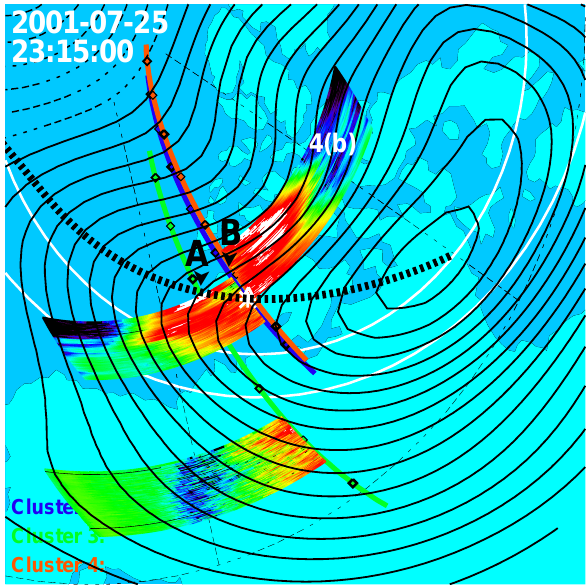
Fig. 5. Composite plot of Cluster magnetic footpoints and iono- spheric convection streamlines for 25 July 2001, at 23:15UT. Over- layed on the magnetic footpoints are 14-min wide sections of the Cluster/CIS flux measurements presented in Plate 1, which are cen- tered on the actual position of the Cluster satellites at 23:15UT. Also indicated by a dashed line is the most likely position of the ion open-closed field line boundary based on the location of the Cluster SC1 satellite position, which entered the cusp at that time, and the SuperDARN convection pattern. This representation revealed that SC1 enters the cusp at about the same position as SC4 7min